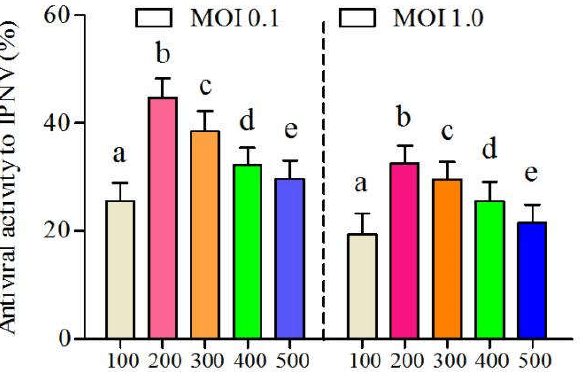
Figure 3. The antiviral activity of CSP on IPNV with a MOI of 0.1 and 1.0, respectively (different letters indicate statistical significance, p <